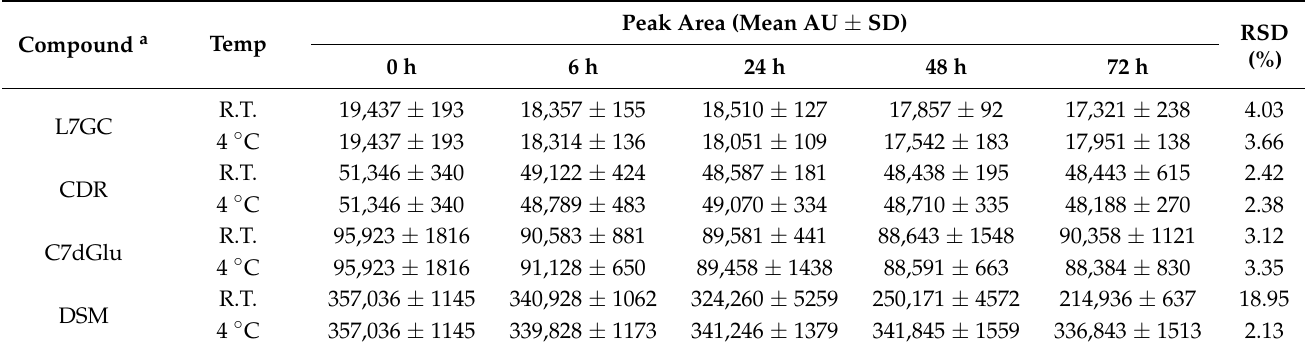
Table 4. Stabilities of L7GC, CDR, C7dGlu, and DSM in sample solutions at room temperature or 4 ◦ C for 0, 6, 24, 48, and 72 h ( n =